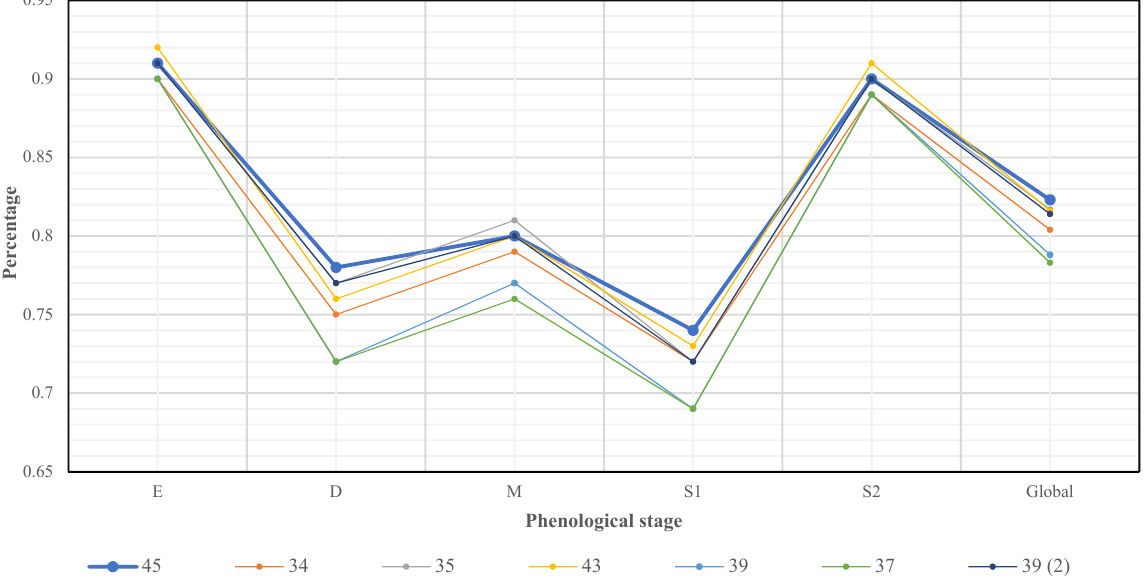
Figure 6. Evaluation of the main characteristics. In series 34, the LISA characteristics were eliminated, series 35 eliminated LBP, series 43 eliminated LAI, series 39 eliminated colour ratios, series 37 eliminated RGB and NIR, and series 39 (2) eliminated L*a*b*.